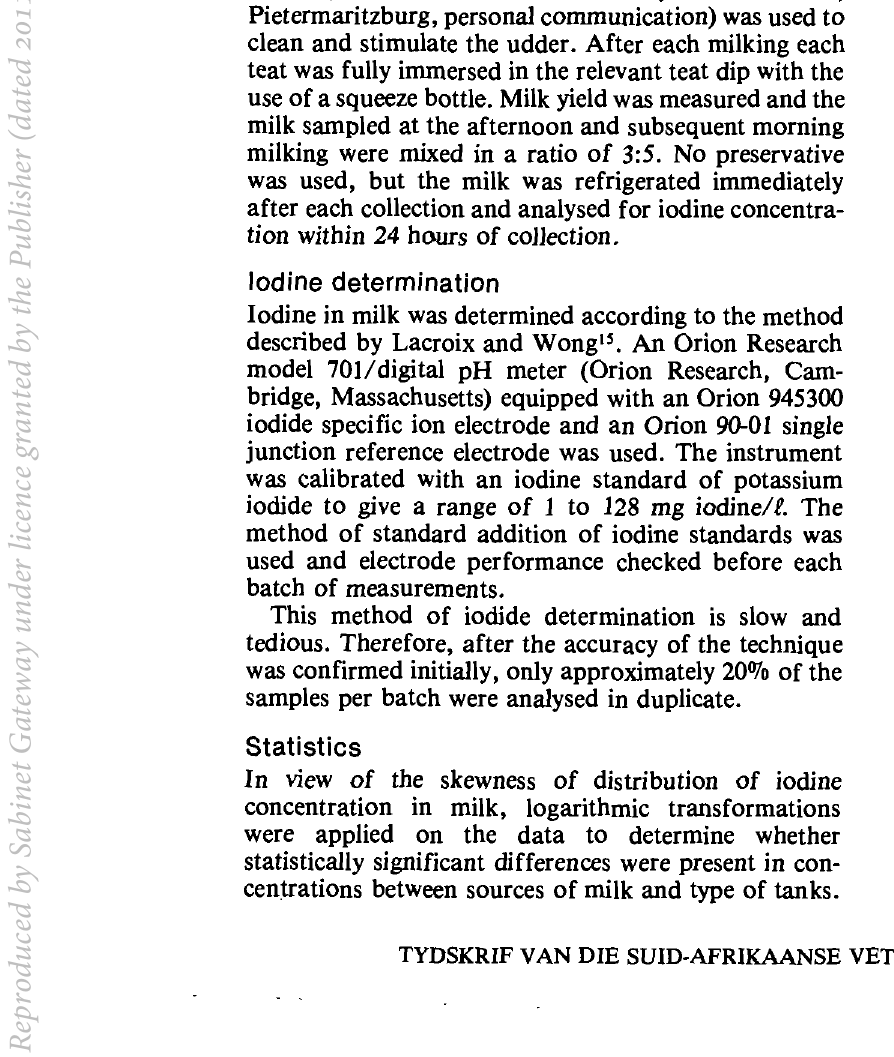
Table 1: Distribution according to iodine 'concentration of mixed milk samples from bulk milk